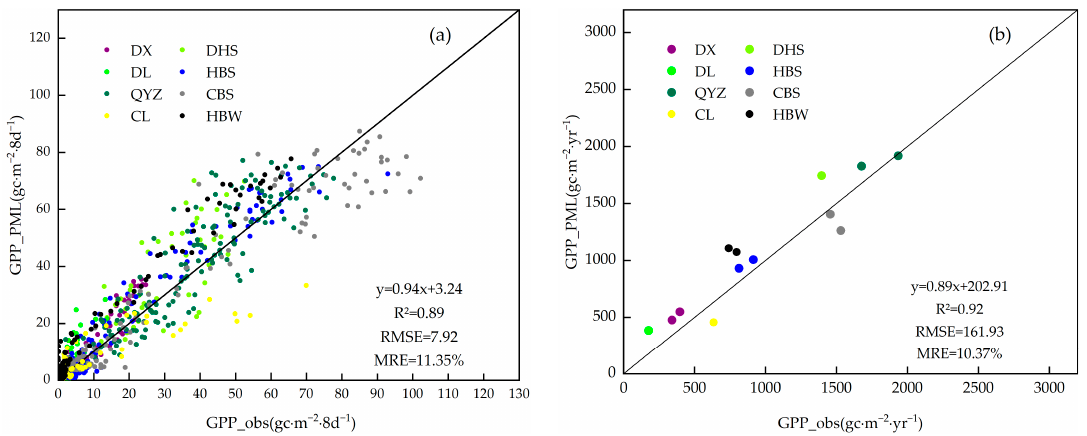
Figure 3. Accuracies of PML_V2 GPP estimates on the ( a ) 8-day scale and ( b ) annual scale based on in-situ observations from six flux stations.